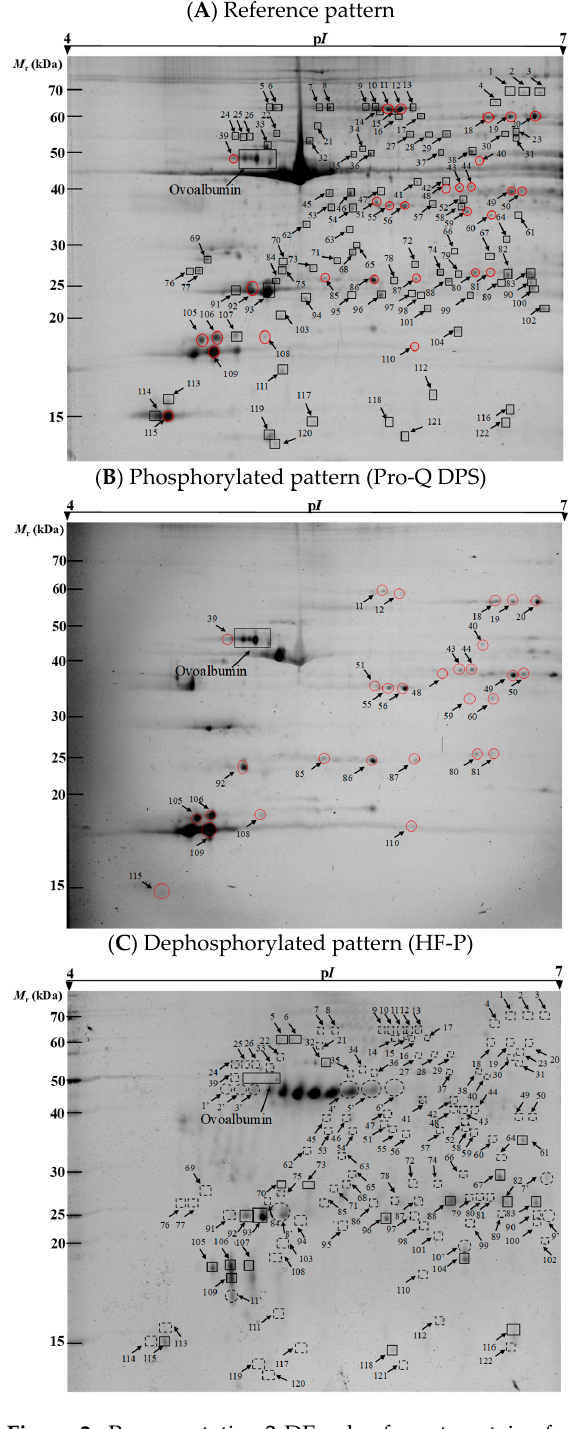
Figure 2. Representative 2-DE gels of meat proteins from LT muscle obtained for three different protocols. ( A ) The 2-DE reference pattern of total protein obtained from untreated samples. Gels were stained with Sypro Ruby stain. ( B ) The 2-DE phosphorylated pattern after staining with the phosphoprotein-specific fluorescent dye Pro-Q DPS. ( C ) The 2-DE dephosphorylated pattern after HF-P treatment and staining with Sypro Ruby. Protein spots with statistically significant differences in phosphorylation rates between both methods (Pro-Q DPS and HF-P) are marked and numbered. Red circles represent phosphorylated protein spots detected by Pro-Q DPS method and with statistically significant differences in PR between both methods. Dashed squares are missing and circles are newly arisen spots after dephosphorylation, with regard to reference